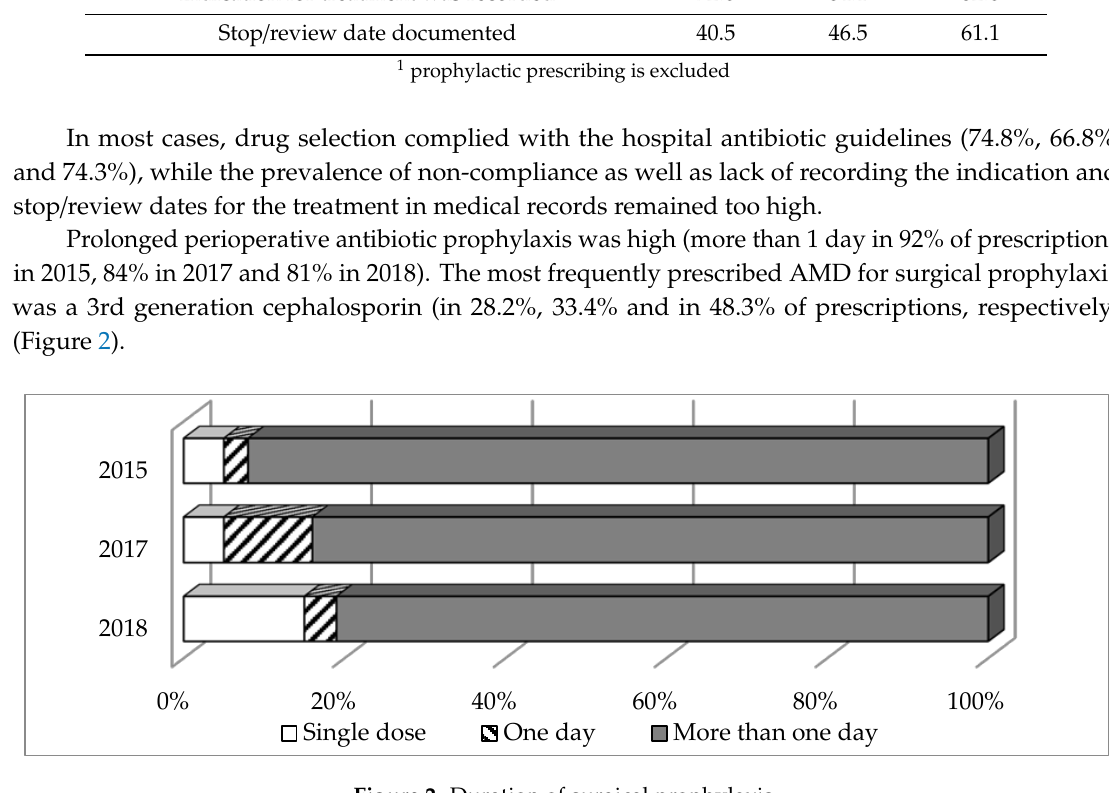
Table 6. Quality indicators of systemic AMD prescribing in four hospital sites with repetitive PPS in 2017 and 2018, %.